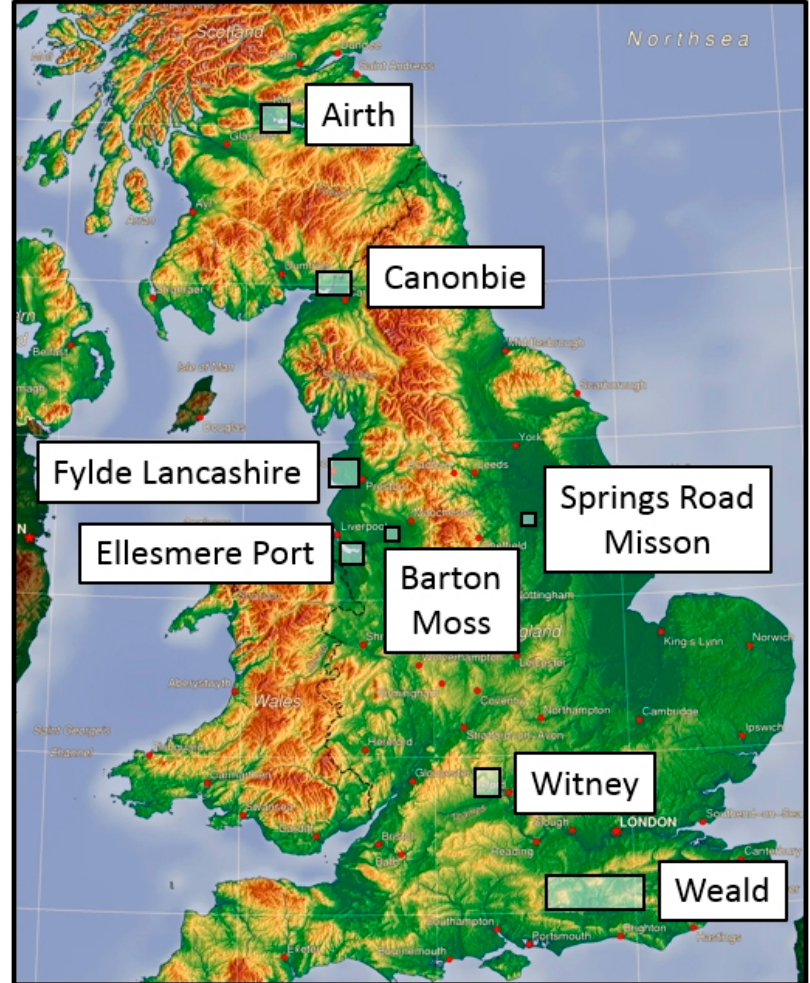
Figure 2. Location map of the case histories discussed in the text.